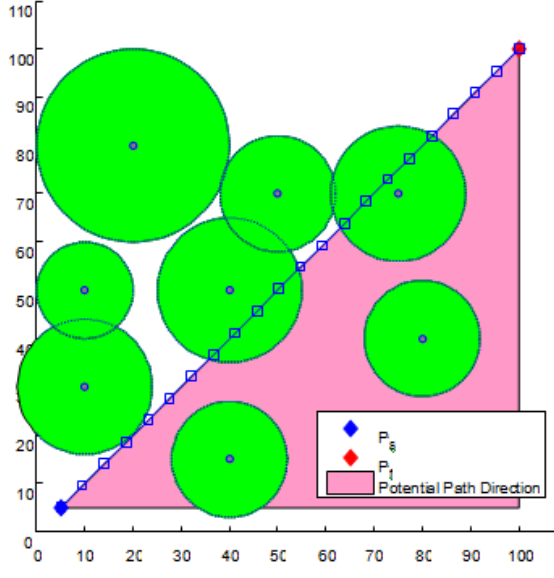
Fig. 2 The potential side of the optimal